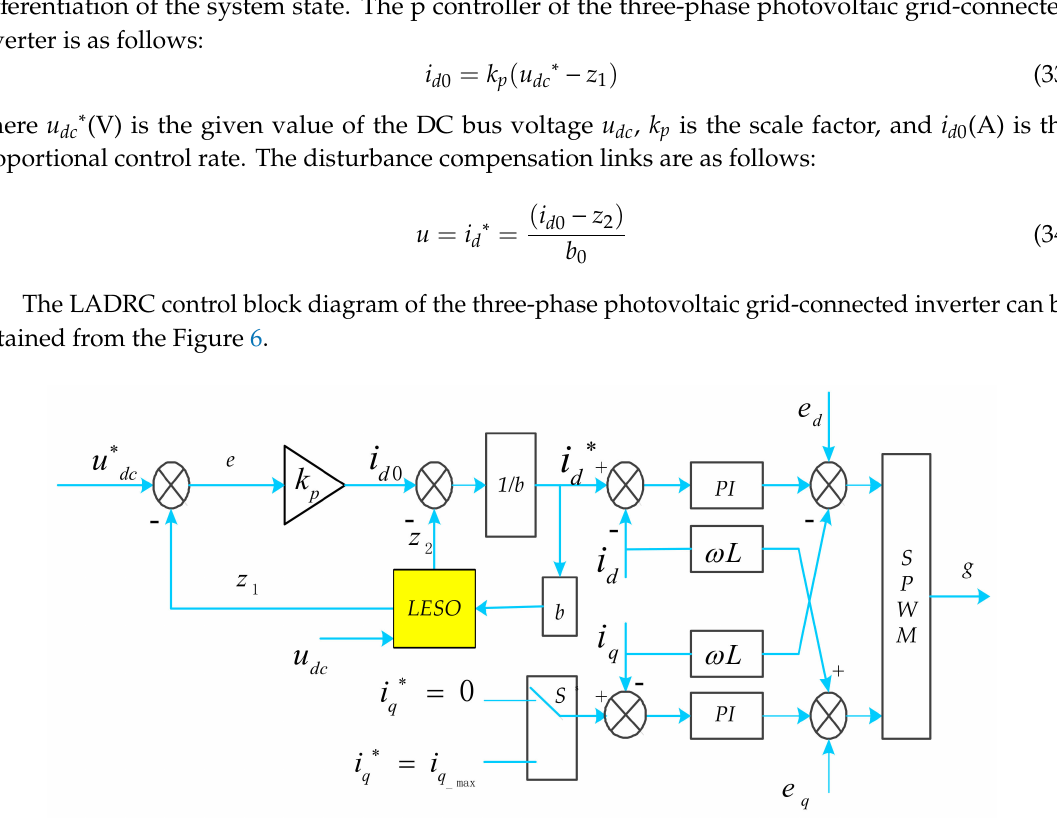
Figure 6. Control block diagram of photovoltaic grid-connected inverter based on